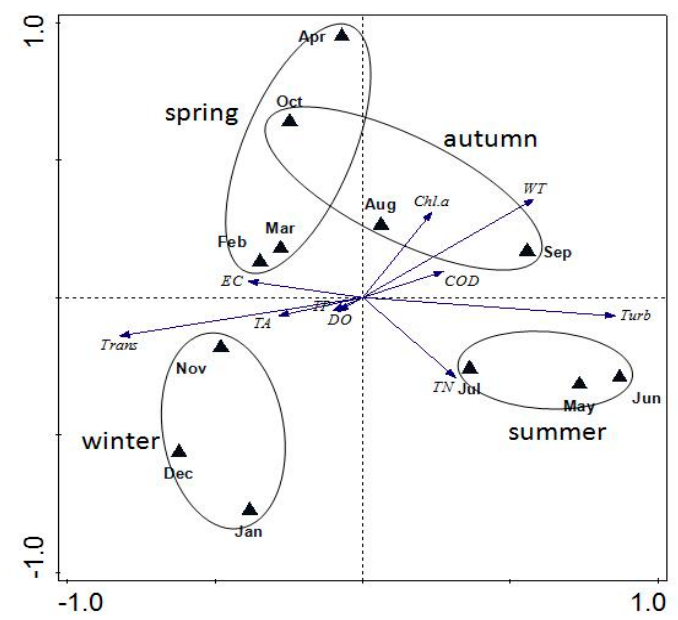
Figure 11. RDA ordination biplot of environmental variables and location distribution from the LR, Figure 10. RDA ordination biplot of environmental variables and time succession from the LR, China, China, 2013–2015.